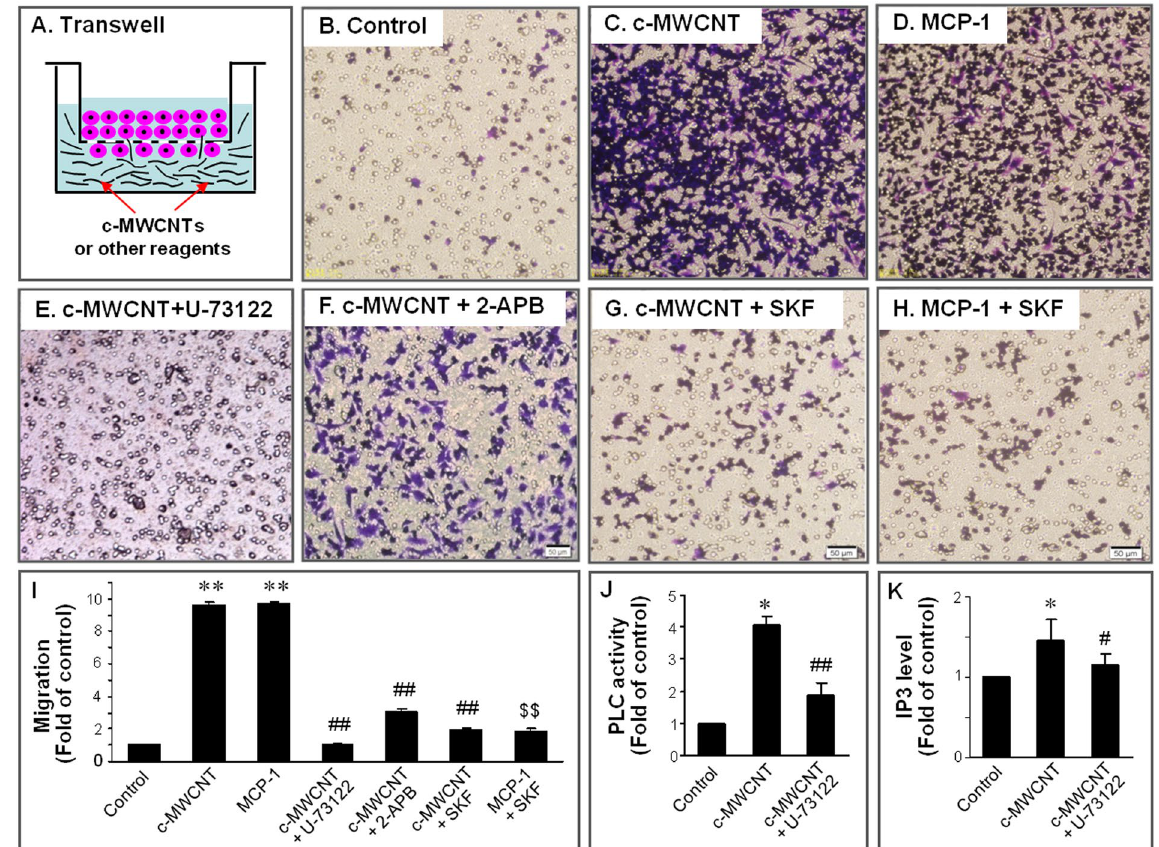
Figure 1. Transwell and ELISA assays showing the migrations, PLC activities and IP3 levels of RAW264.7 macrophages at different treatment conditions. ( A ) A schematic diagram of the transwell assay. ( B ) Through ( H ) crystal violet stains of migrated RAW264.7 macrophages at different treatment conditions. Migrated RAW264.7 cells were stained purple-blue. The small circles in the images were PET membrane pores that were not stained purple-blue. Note that c-MWCNTs and MCP-1 (positive control drug) strongly stimulated the migration of RAW264.7 macrophages, while pretreatment with PLC inhibitor U-73122, IP3R antagonist 2-APB, or CRAC channel blocker SK&F96365 (SKF) significantly abolished the migration-stimulating effect of c-MWCNTs. Scale bar: 50 μ m. ( I ) Statistical summary of RAW264.7 cell migration at different conditions. ** P < 0.01 vs . control. ## P < 0.01 vs . c-MWCNT. $$ P < 0.01 vs . MCP-1. N = 3 in each group. U-73122, 2-APB and SK&F96365 alone did not affect the migration (not shown). ( J and K ) Statistical results of ELISA assays, respectively, showing the PLC activities and IP3 levels of RAW264.7 cells at different conditions. ** P < 0.01 vs . control. ## P < 0.01 vs . c-MWCNT. N = 3 in each